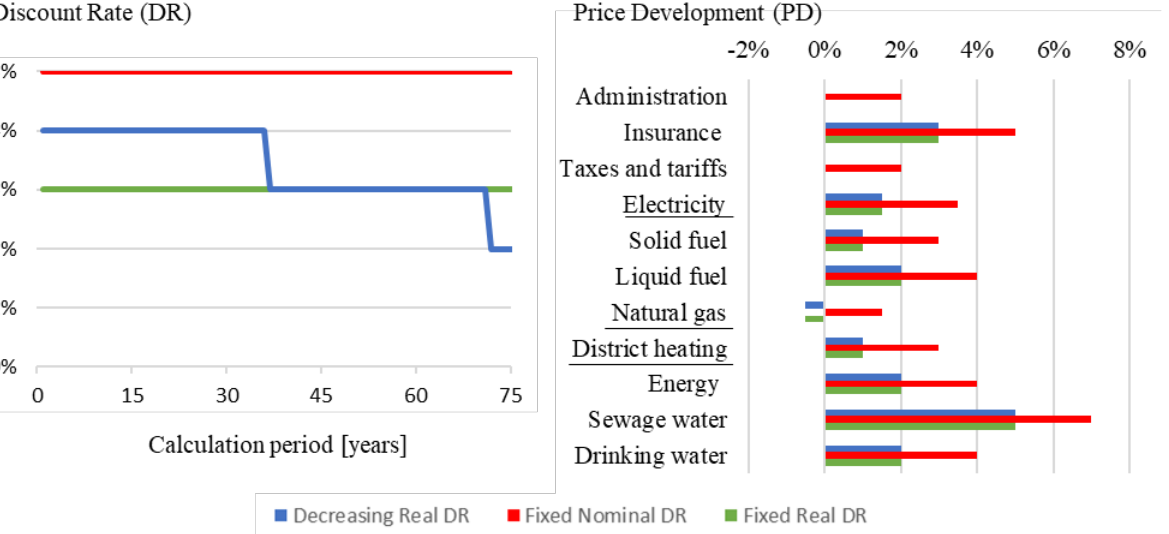
Figure 2. Discount rate types ( left ) and price development for different cost types ( right ). Data source [31].